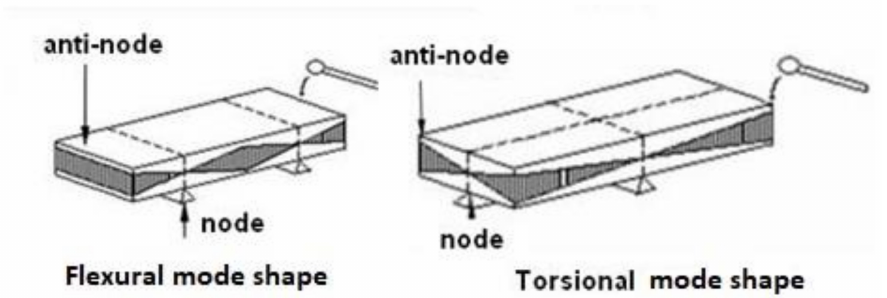
Figure 1. Support, excitation position and measurement positions for impulse excitation technique (IET) tests on